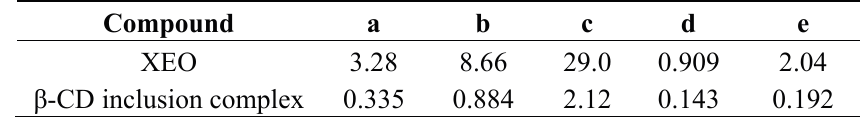
Table 2. The contents of the five active compounds (%): ( a ) senkyunolide A; ( b ) 3- n -butylphthalide; ( c ) Z -ligustilide; ( d ) dehydrocostus lactone; ( e ) α